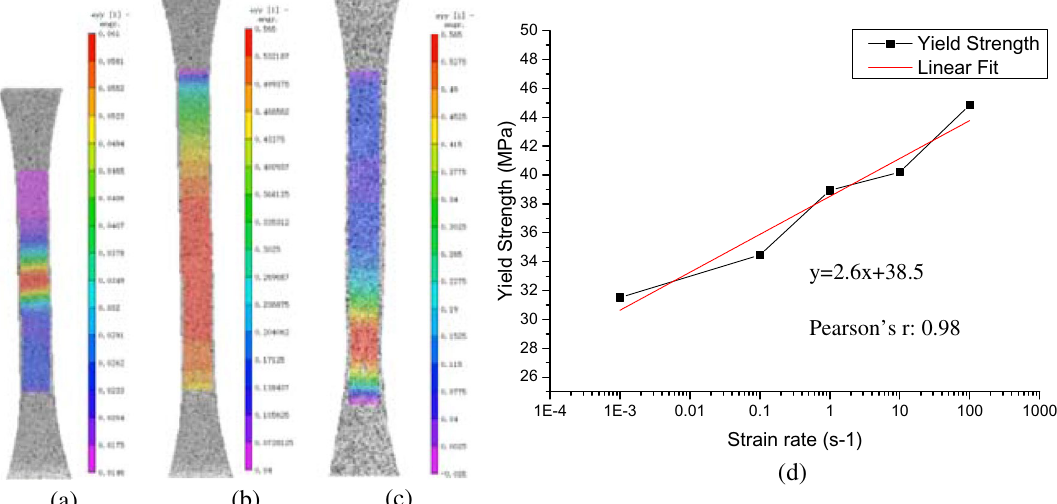
Figure 12. DIC strain contour of HIPS at ( a ) initiation of necking and ( b ) final stage of necking before fracture showing uniform necking; ( c ) DIC strain contour of ABS before fracture showing apparent necking/ strain localization and ( d ) measured yield stress as a function of the logarithm of strain rate for HIPS at room temperature.